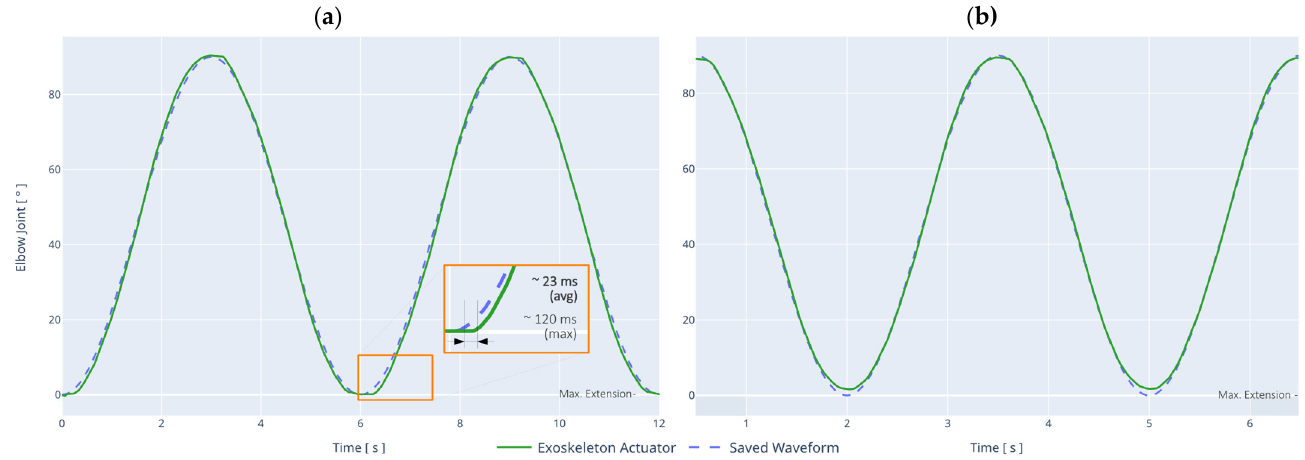
Figure 11. Autonomous Mode Controller (AMC) test using a sinusoidal waveform. Part ( a ) angular velocity ω = 30 °/s (0.52 rad/s). Part ( b ) angular velocity ω = 60 °/s (1.05 rad/s).